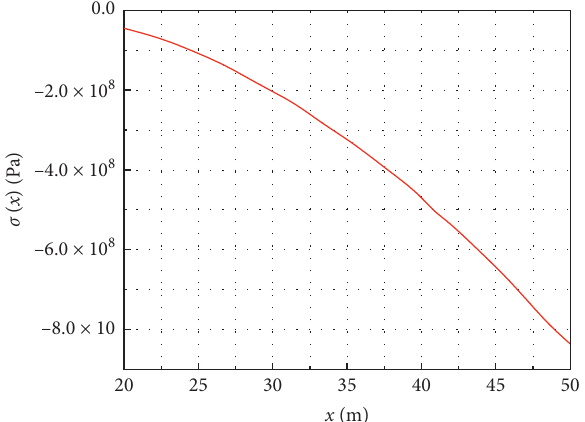
Figure 13: The variation of bending stress (IV).